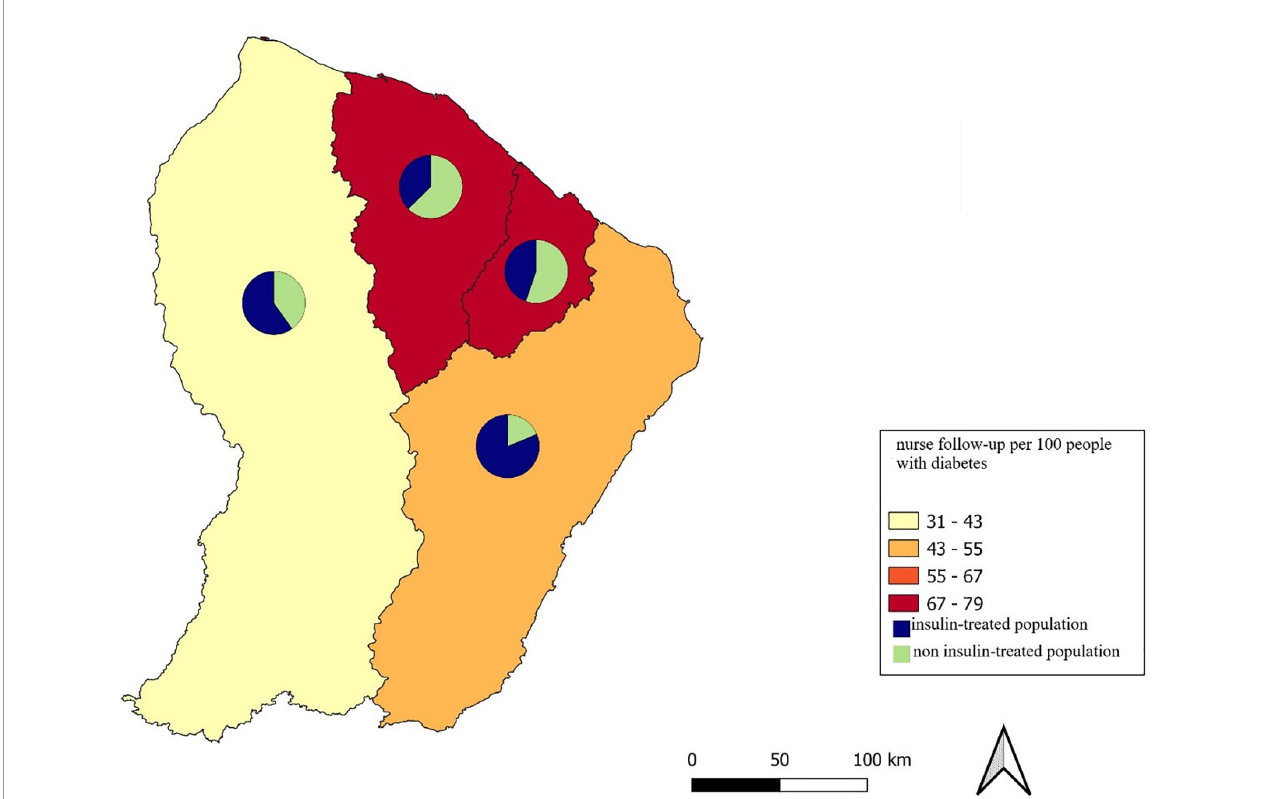
FIGURE 6 | Distribution of nursing care in the